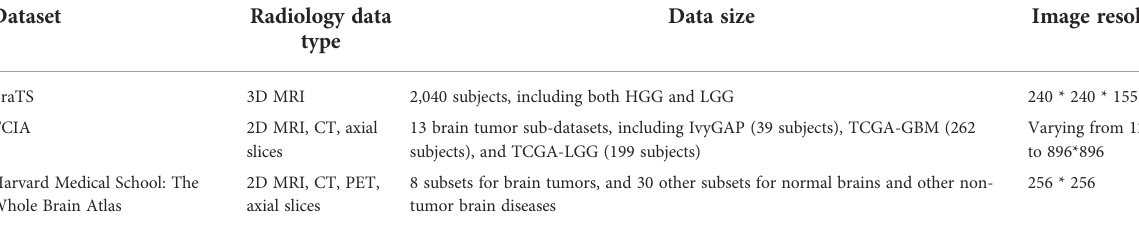
TABLE 1 List of three major sources for radiomic neuro-oncology public datasets.